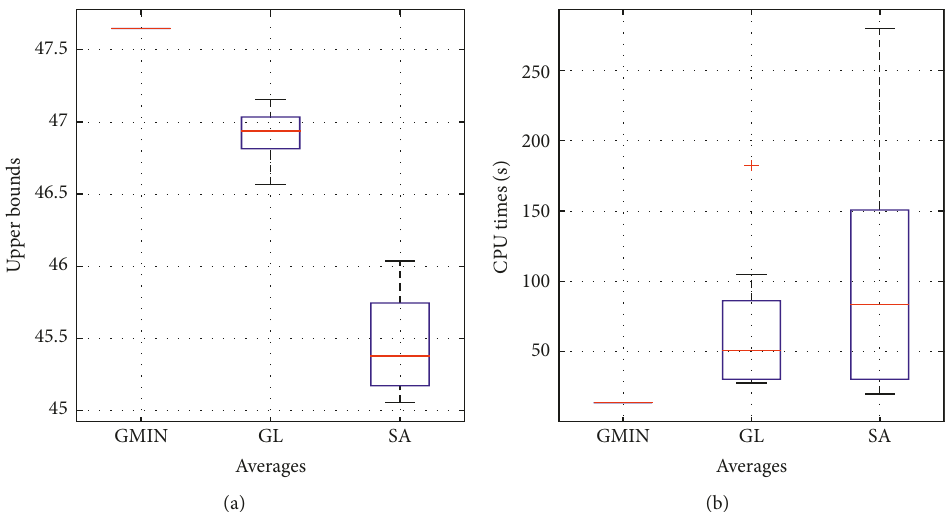
Figure 8: (a) Average upper bounds and (b) CPU times in seconds for the instance #11 in Table 1 while using a radial coverage value of 0.2km.